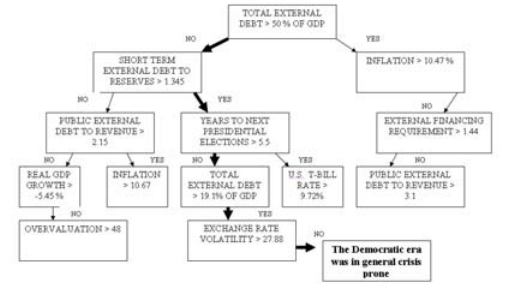
Figure 1: Democratic Era analysis using BRT